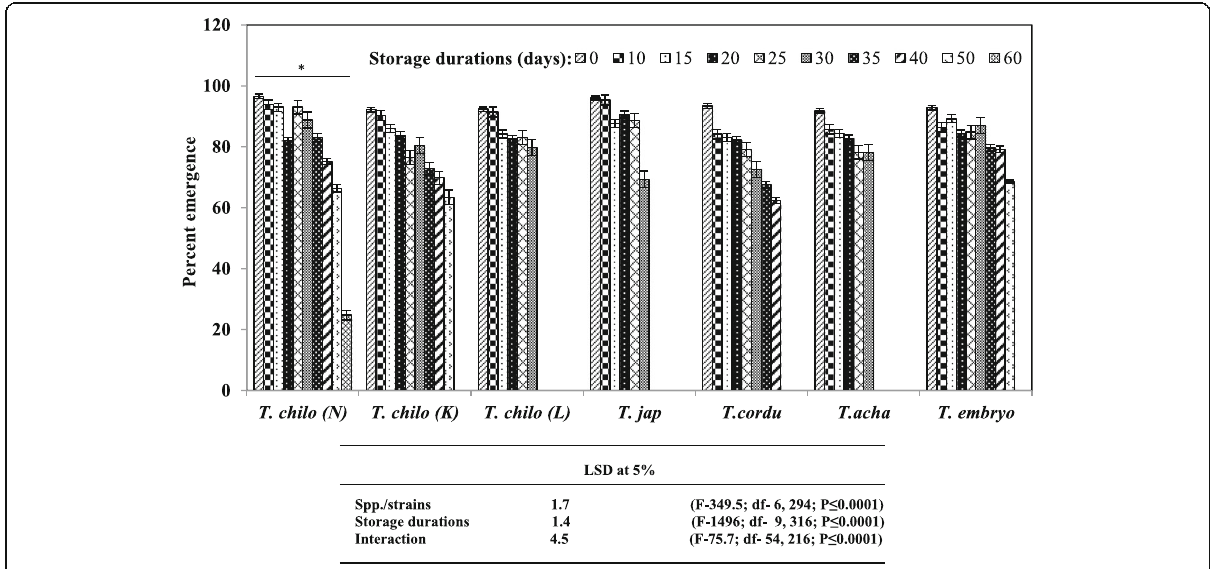
Fig. 1 Emergence of different spp./strains of Trichogramma after their pupal stage storage on Corcyra cephalonica eggs at 10 °C (L:D 8:16, RH 70 ± 10%). Control treatment (0 days): un-stored batch of Trichogramma pupae. T. chilo (N) , Trichogramma chilonis Nilgiris; T. chilo (K) , T. chilonis Kodaikanal; T. chilo (L) , T. chilonis Lab; T. jap , T. japonicum ; T. cordu , T. cordubensis ; T. acha , T. achaeae ; T. embryo , T.